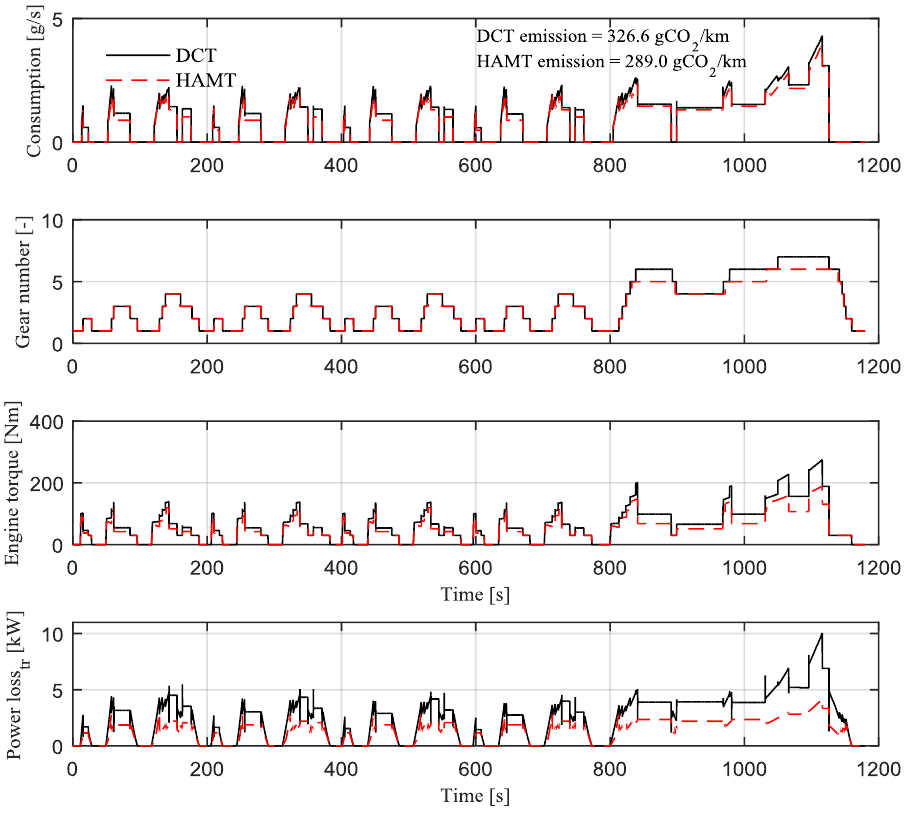
Figure 12. Simulation results for NEDC driving cycle; comparison between DCT and HAMT.